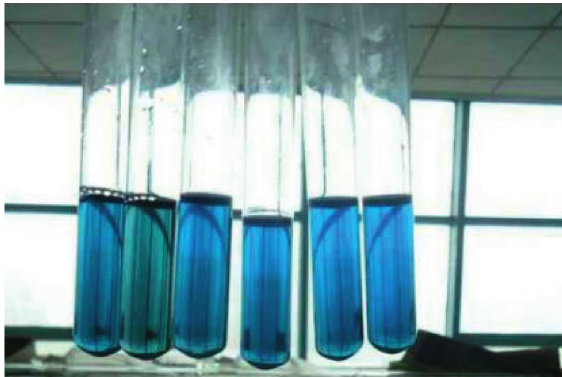
Figure 7: Blue solution obtained on addition of